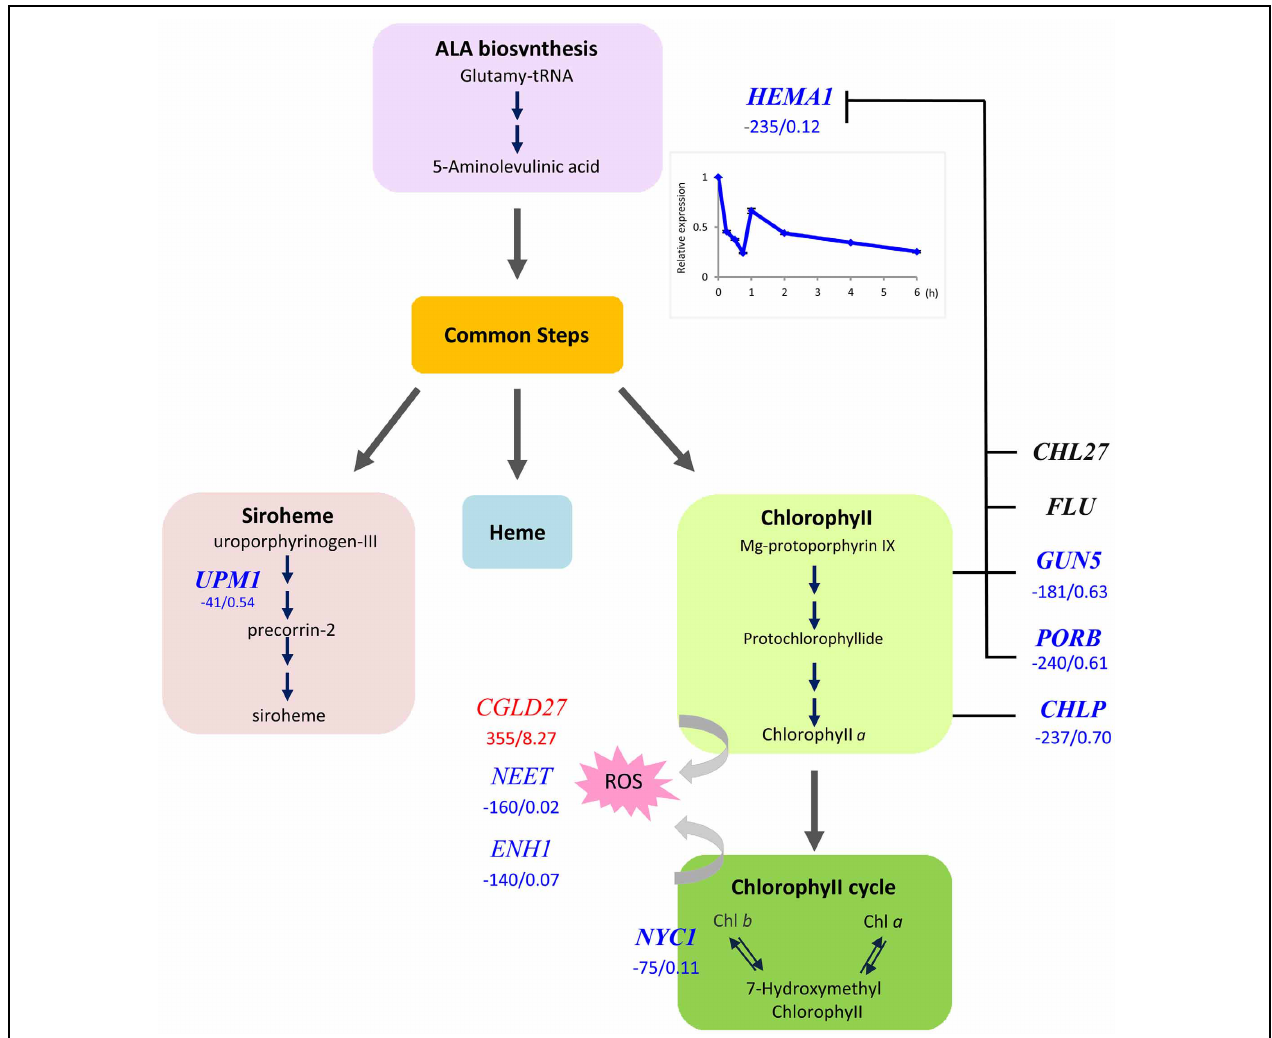
samples from Fe deficient compared with Fe-sufficient plants. Arrows denote steps that are likely regulated by the [Fe]. Inset shows the time-course of HEMA1 expression in leaves after transfer to Fe-deplete